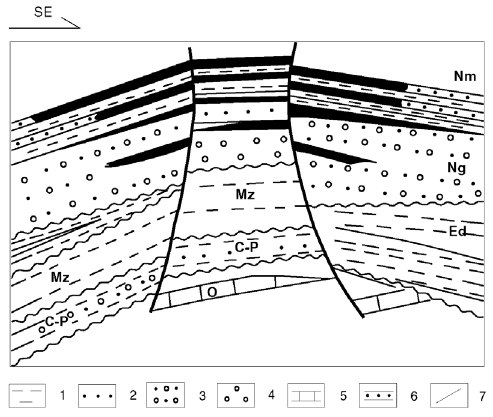
Fig. 3. Cross section of the Gangxi oil field (Song Mingliang, 1991): Nm-Upper Tertiary Minghuazhen formation; Ng-Upper Tertiary Guantao formation; Ed – Lower tertiary Dongying formation; Mz – Meso- zoic; C-P – Carbo-Permian; O – Ordovician; 1 – mud- stone; 2 – sandstone; 3 – sandy conglomerate; 4 – con- glomerate; 5 – limestone; 6 – oil; 7 – fault.